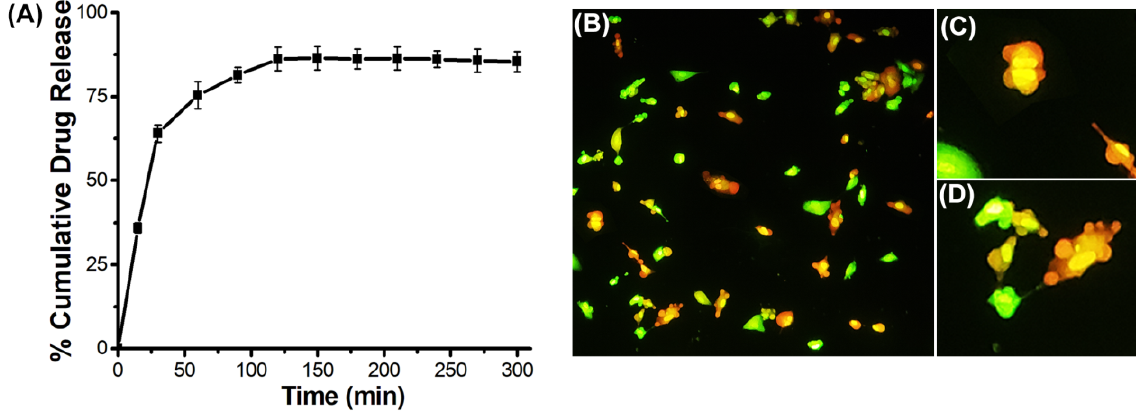
Figure 8. ( A ) Drug release profile for Dox-encapsulated MNF@C-OSAs. ( B ) AO/EB double-stained image of Dox-encapsulated MNF@C-OSA-treated A549 cells (10×). ( C ) Condensed nuclei (40×). ( D ) Membrane blebbing and release of apoptotic bodies formed from the treated cells (40×).